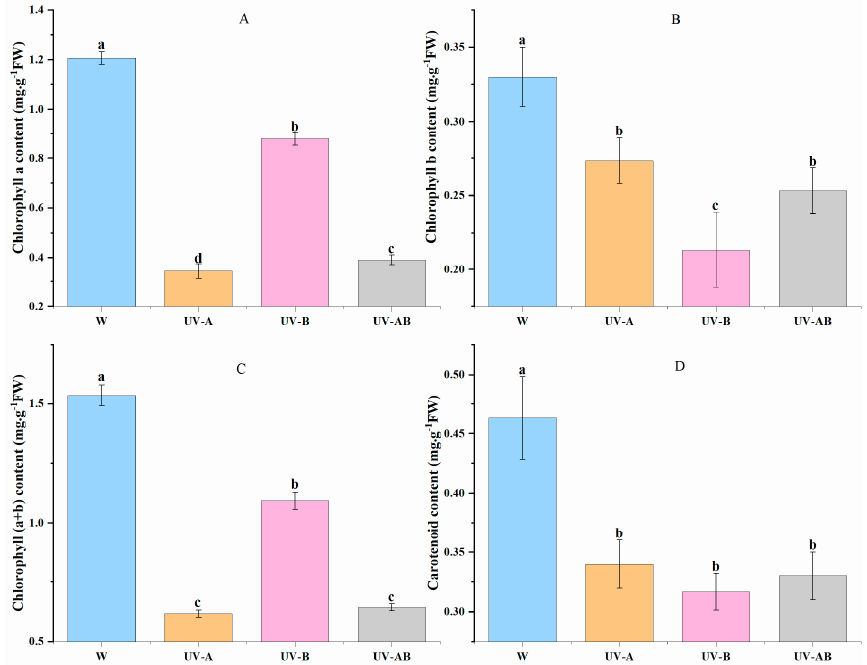
Figure 2. Photosynthetic pigment content in young shoot under different treatments. ( A ) Chlorophyll a contents. ( B ) Chlorophyll b contents. ( C ) Chlorophyll (a + b) contents. ( D ) Carotenoid contents.